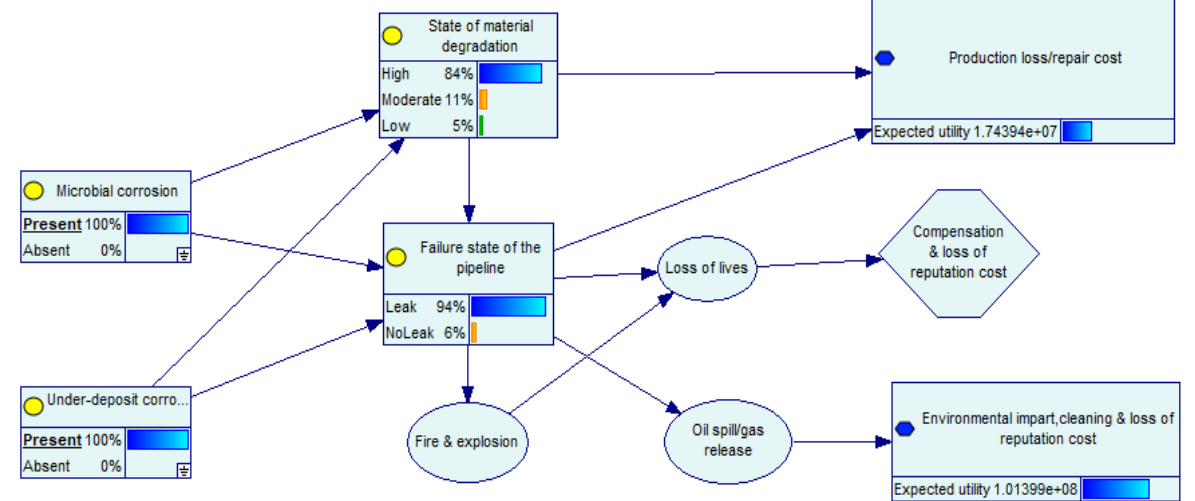
Figure 3. Impact of evidence on the corrosion nodes on the predicted economic losses.